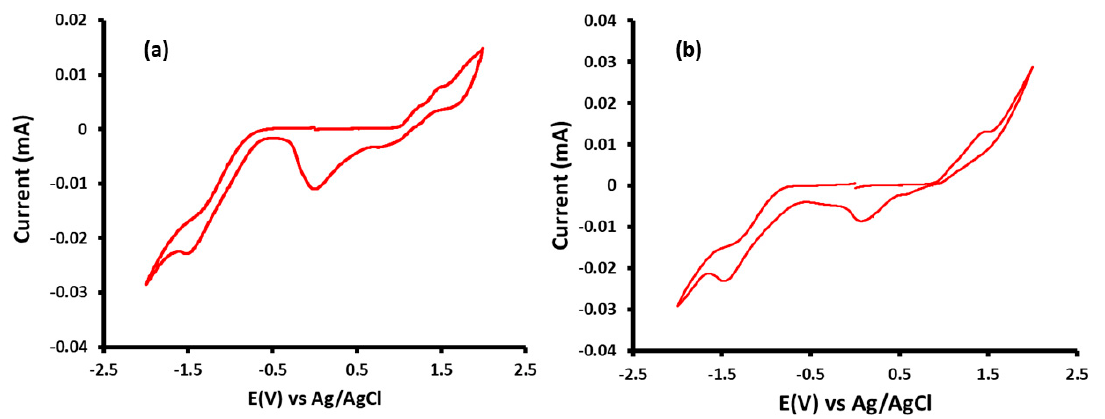
Figure 2. Cyclic voltammogram curves of ( a ) TDPP-T and ( b ) TDPP-EDOT .